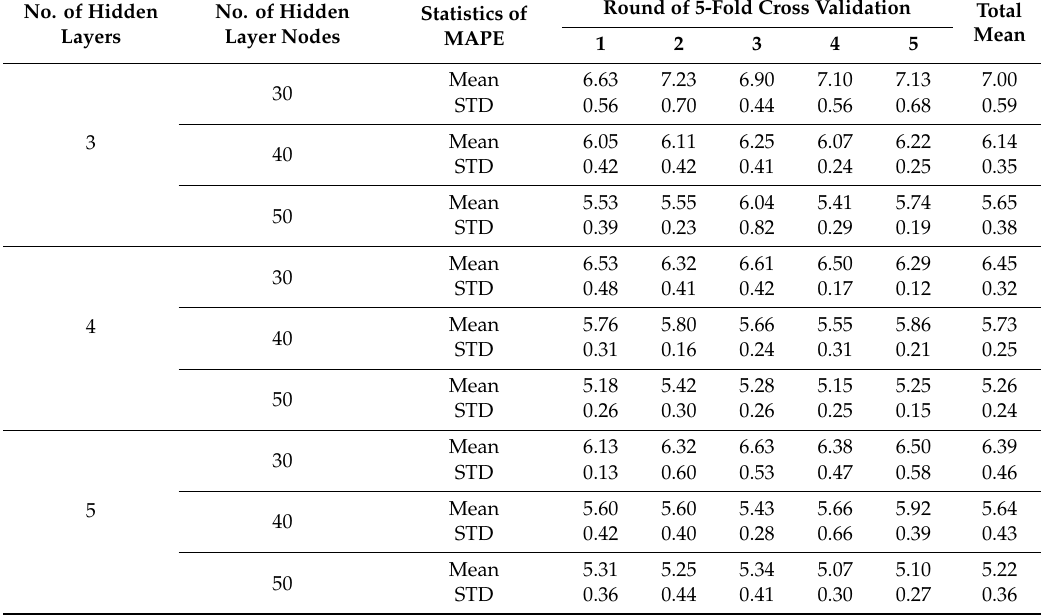
Table 8. Statistical analysis results of MAPE of DNN models for predicting afternoon ore production according to the number of rounds of 5-fold cross validation.